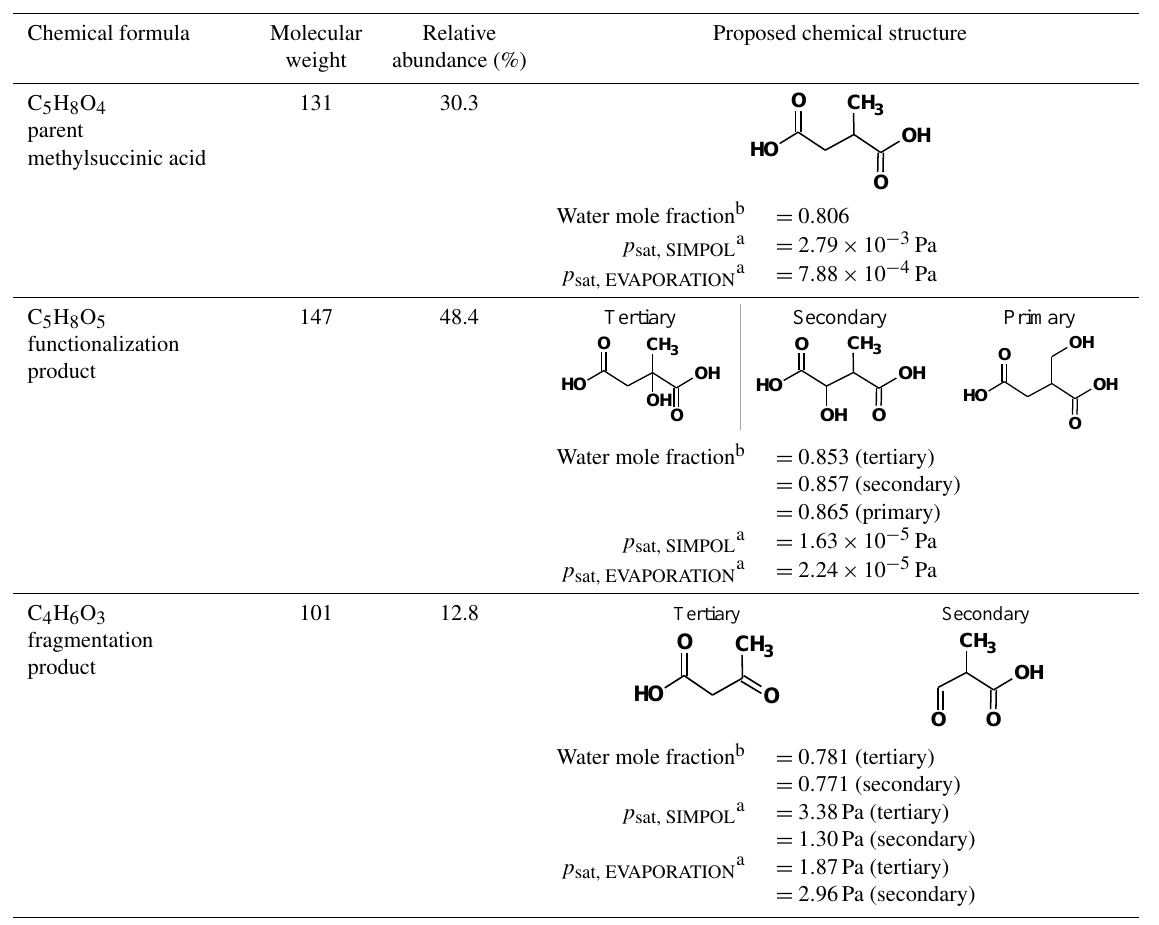
Table 2. Major reaction products observed during the heterogeneous OH oxidation of aqueous methylsuccinic acid droplets. The relative abundance is reported at the maximum OH exposure (1.47 × 10 12 molecule cm −3 s). Chemical Formula